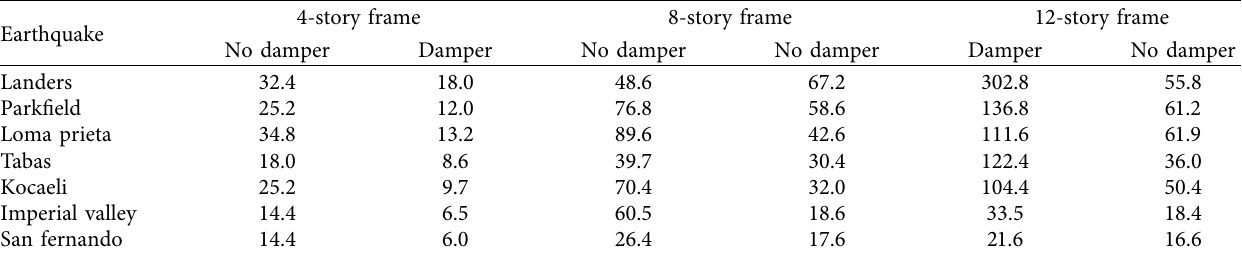
Table 3: Roof displacement values in centimeters for near-field